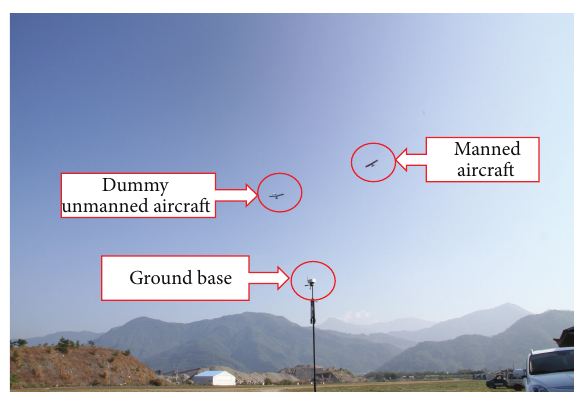
Figure 6: Two ultralight aircraft for flight test.